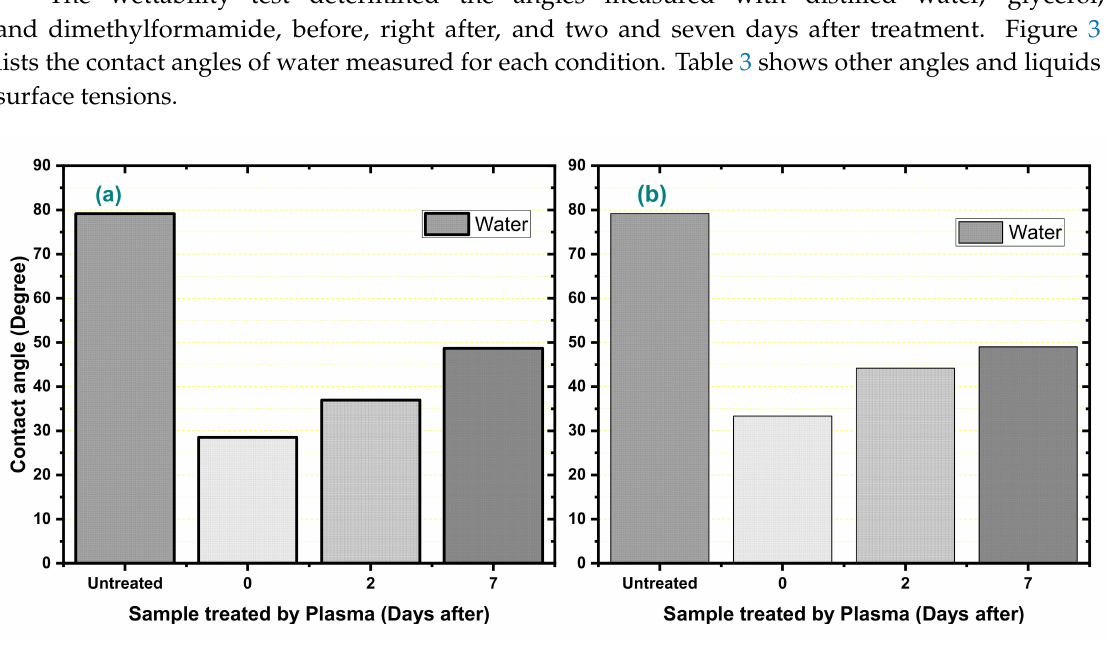
Figure 3. Values of the angles of water obtained before and after the treatment in ( a ) argon and ( b ) oxygen. Table 3. Values total, polar ( γ lp ) and dispersive ( γ lp ) coordinates of superficial tensions, and the values of contact angle for the